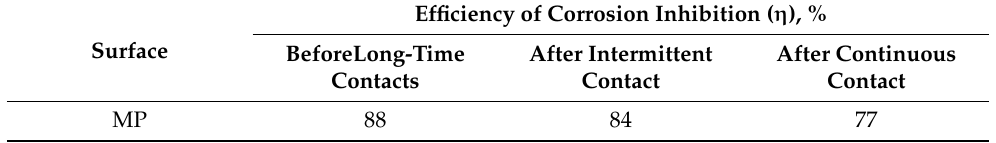
Table 4. Corrosion inhibition efficiency ( η ) of micropillar surface (MP) prior to and after long-time contacts with NaCl solution, estimated using Equation (4).